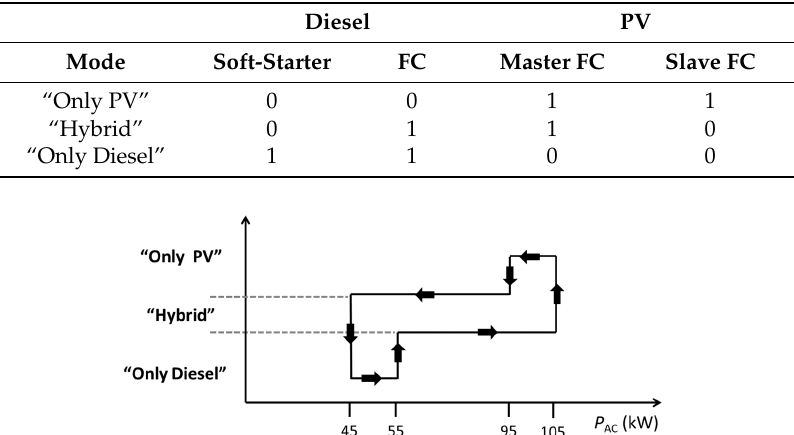
Table 1. ON(1)/OFF(0) status of the different operating modes.